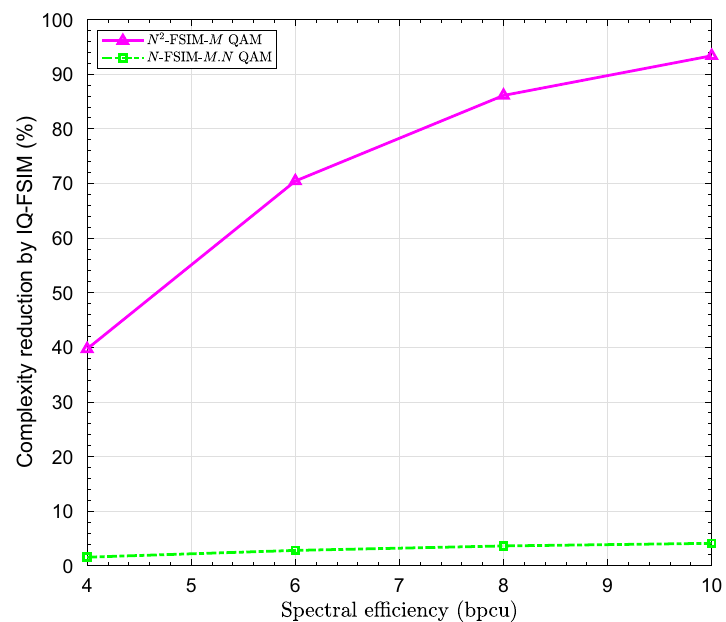
Fig. 15 Computational complexity reduction by the proposed N -IQ-FSIM-QPSK ( M = 4 ) compared to FSIM scheme using either same modulation order or same number of filter